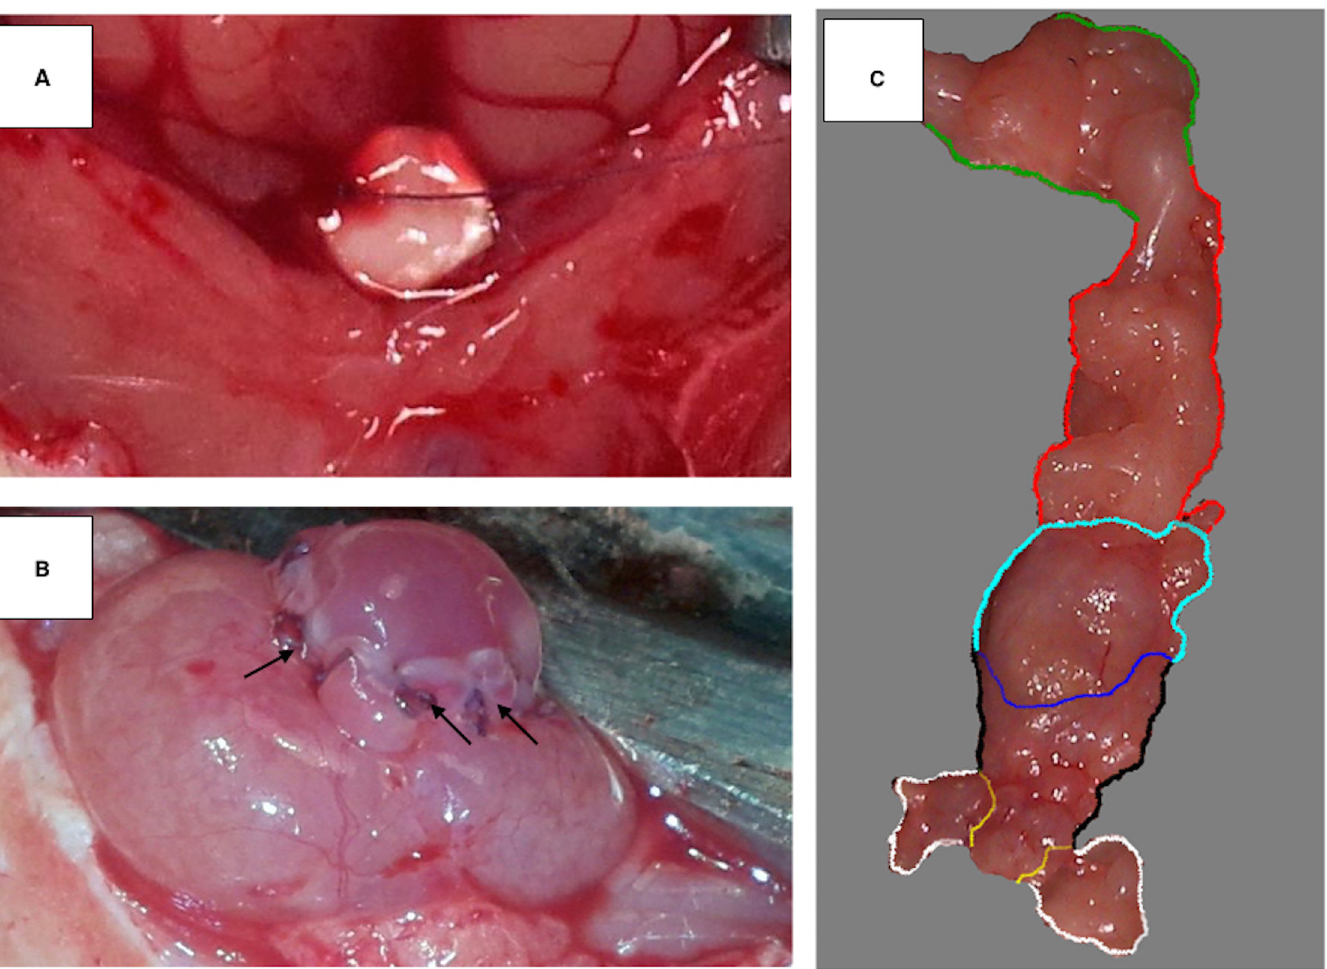
Fig 5. Urinary bladder augmented with biocomposite. (A) Biocomposite material scaffold prepared for the suture procedure. (B) Urinary bladder after the augmentation procedure. Single fixing sutures are visible (black arrows). The optimal compliance of the biocomposite material scaffold allowed for bladder filling shortly after the surgical procedure. (C) Resected reconstructed bladder 3 months after augmentation. The regenerated bladder wall (blue and cyan line was well integrated with the native bladder wall (black line). The borderline between the intact part of the bladder and the reconstructed one was indistinct and without scar formation (blue line). The upper surface of regenerated bladder wall (cyan line) was covered with adipose tissue forming a vascular pedicle (red line) derived from the omentum majus (green line). The bladder neck (yellow line) can be observed with adjacent fragments of seminal vesicles (white